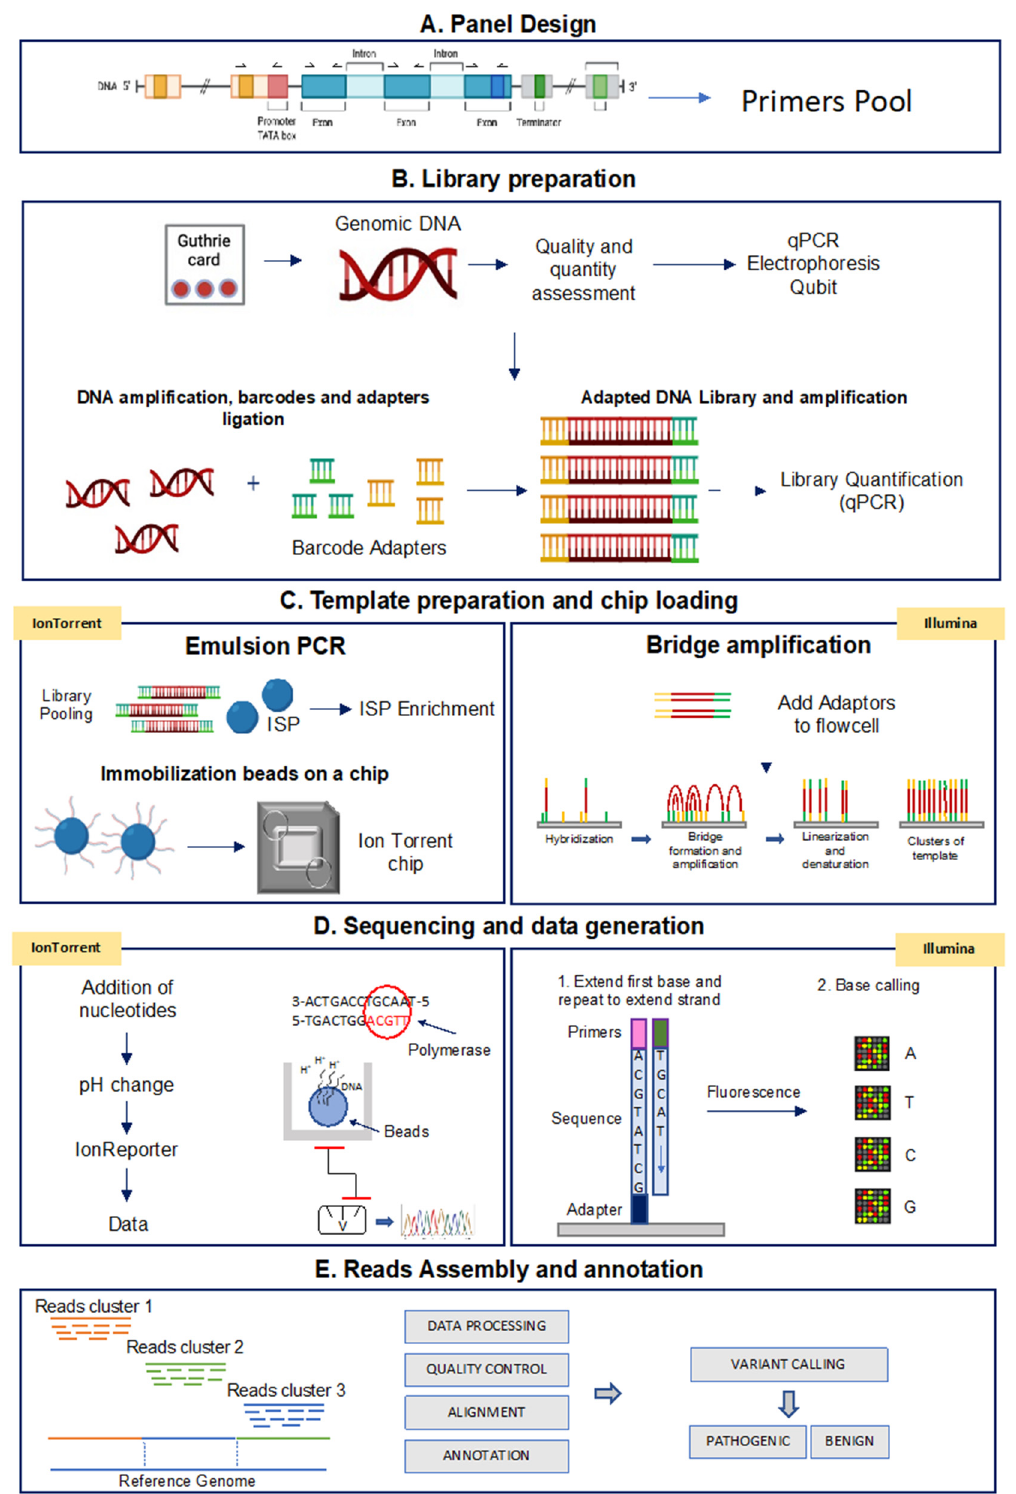
Figure 2. Analytical workflow of targeted sequencing for the Ion Torrent and Illumina methods. ( A ) Panel design: the Designer software helps to create custom assays based on PCR target selection. ( B ) Library preparation: library construction is the preparation of the nucleic acid target into a form compatible with the sequencing system to be used. ( C ) Template preparation and chip loading: target enrichment is used in NGS workflows to capture only genomic DNA regions of interest. ( D )